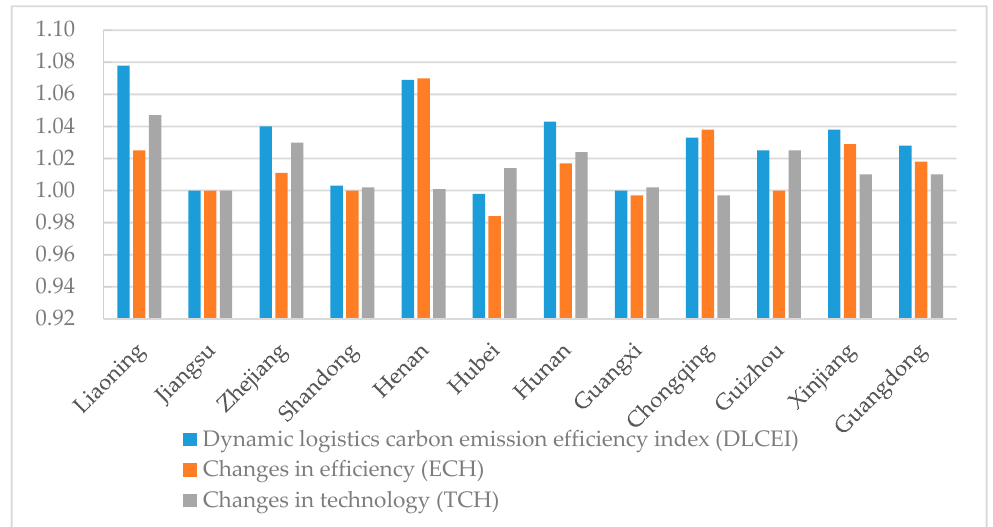
Figure 5. Annual average dynamic carbon emissions efficiency of the logistics industry (DLCEI) and decomposition of each pilot region into TCH and ECH values.